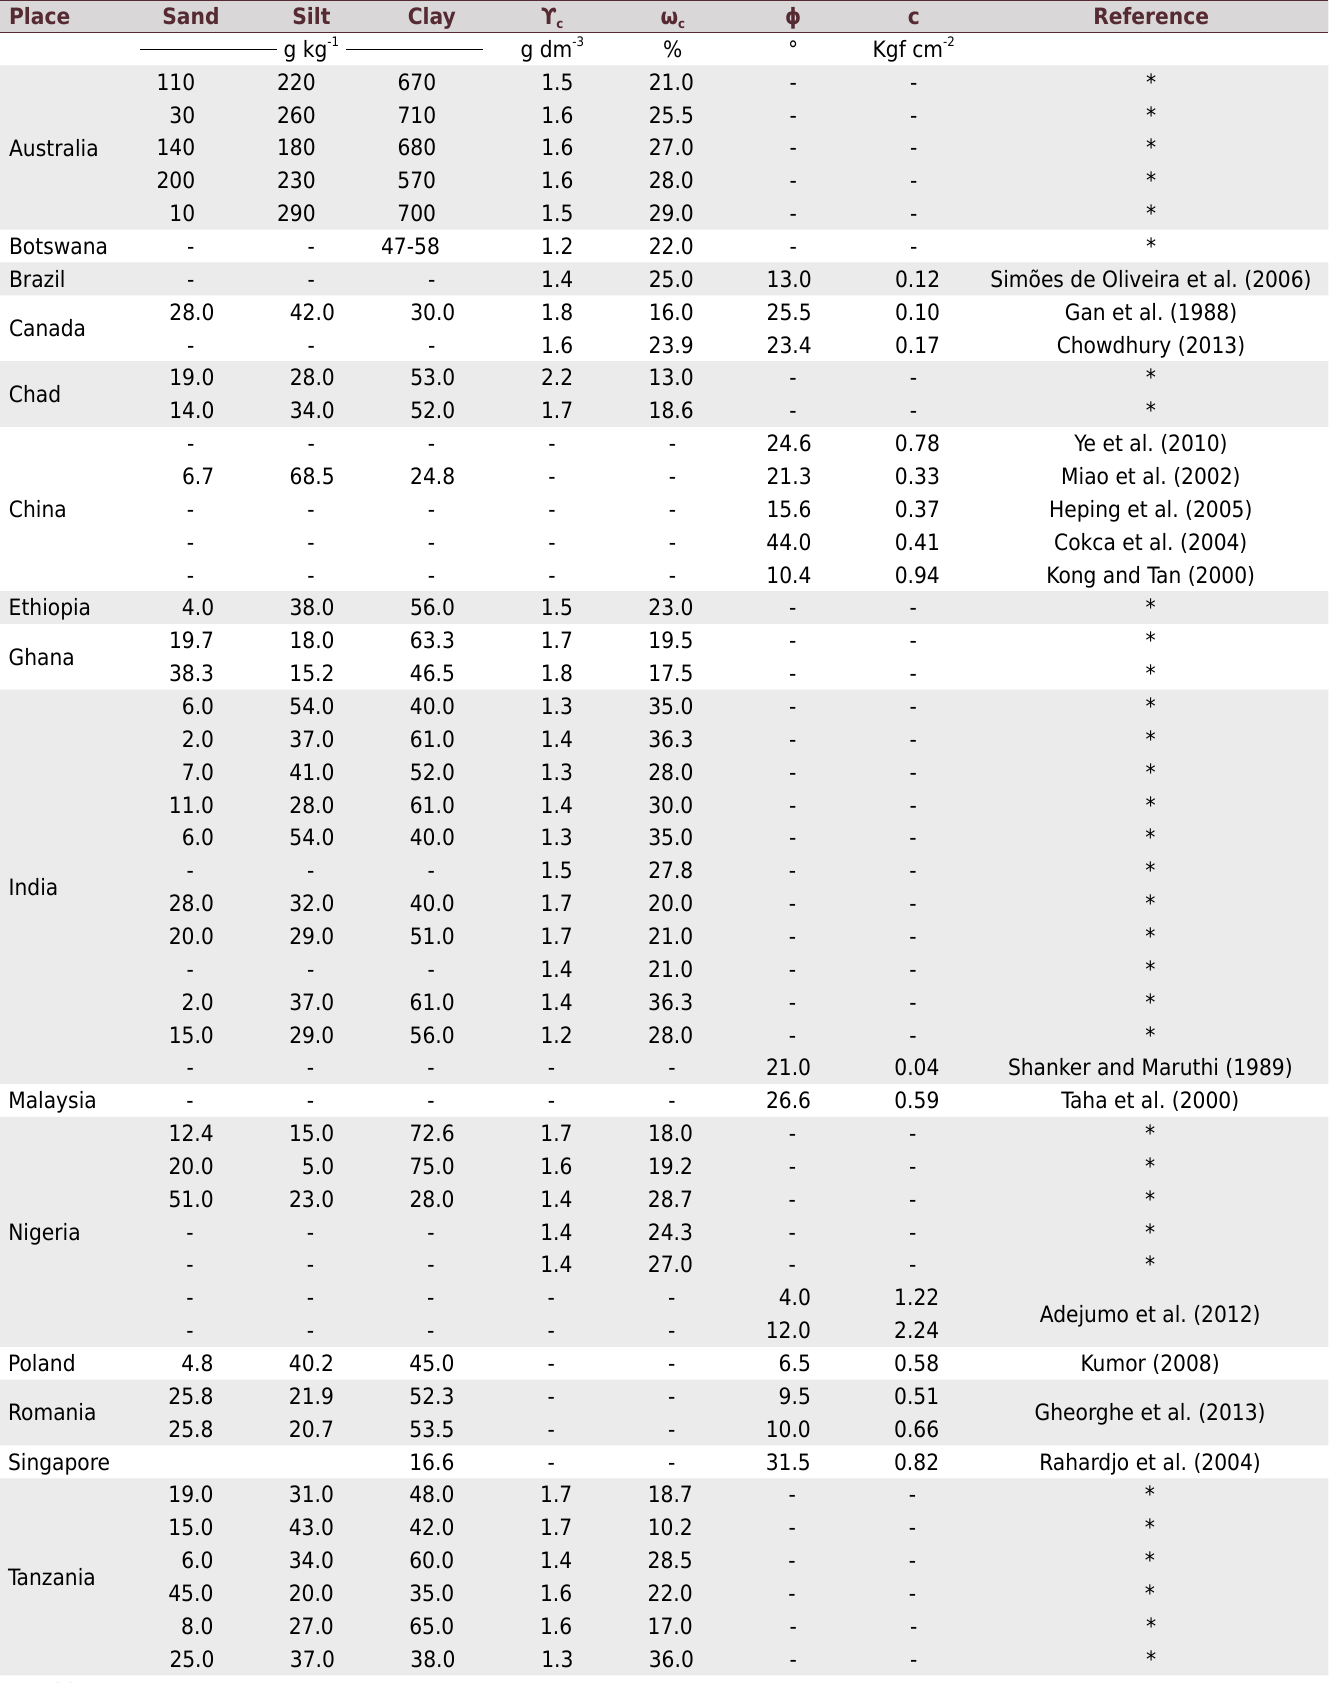
Table 10. Geotechnical properties of expansive soils worldwide Place Sand Silt